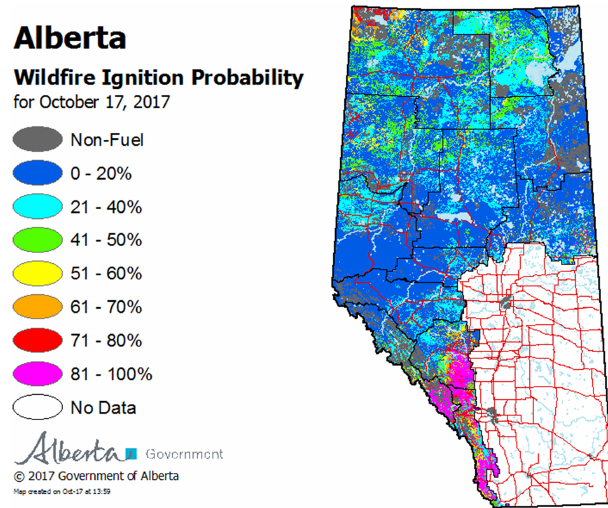
Figure 5. Wildfire ignition probability ( P I ) in Alberta, Canada (http://wildfire.alberta.ca, last access: 17 October